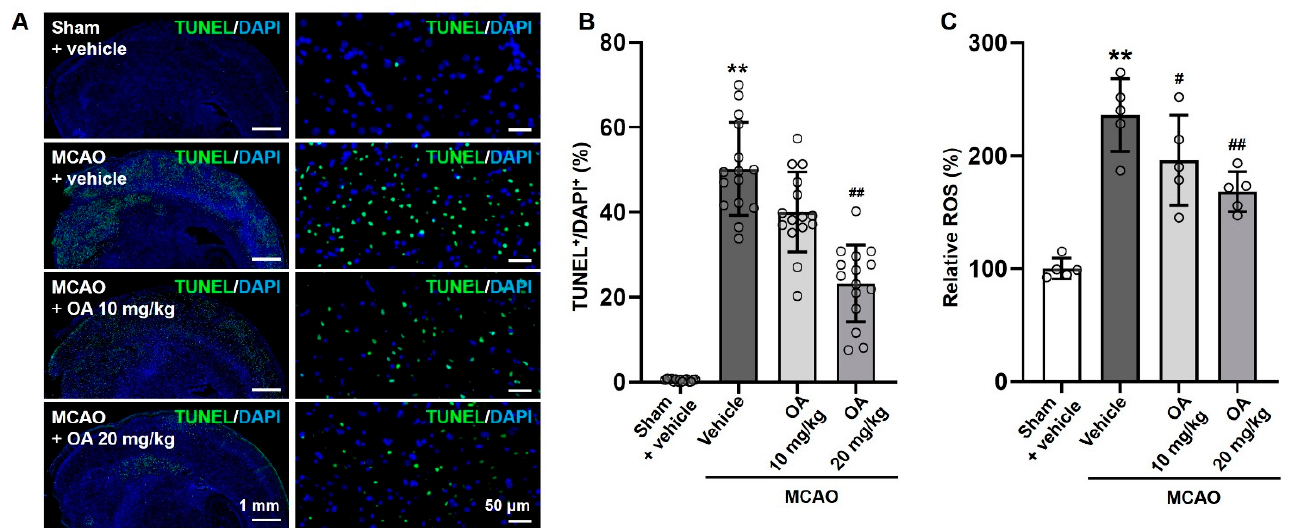
Figure 4. OA administration reduced cellular apoptosis in MCAO rats. ( A ) Representative images of TUNEL staining and ( B ) quantitative analysis of the proportion of TUNEL + cells in the infarcted area in MCAO rats with or without OA administration. ( C ) Relative ROS production in MCAO rats with or without OA administration. Data are shown as the mean ± S.D. Scale bars: 1 mm and 50 μ m . ** p < 0.01 versus the sham + vehicle group; # p < 0.05 and ## p < 0.01 versus the MCAO + vehicle group.